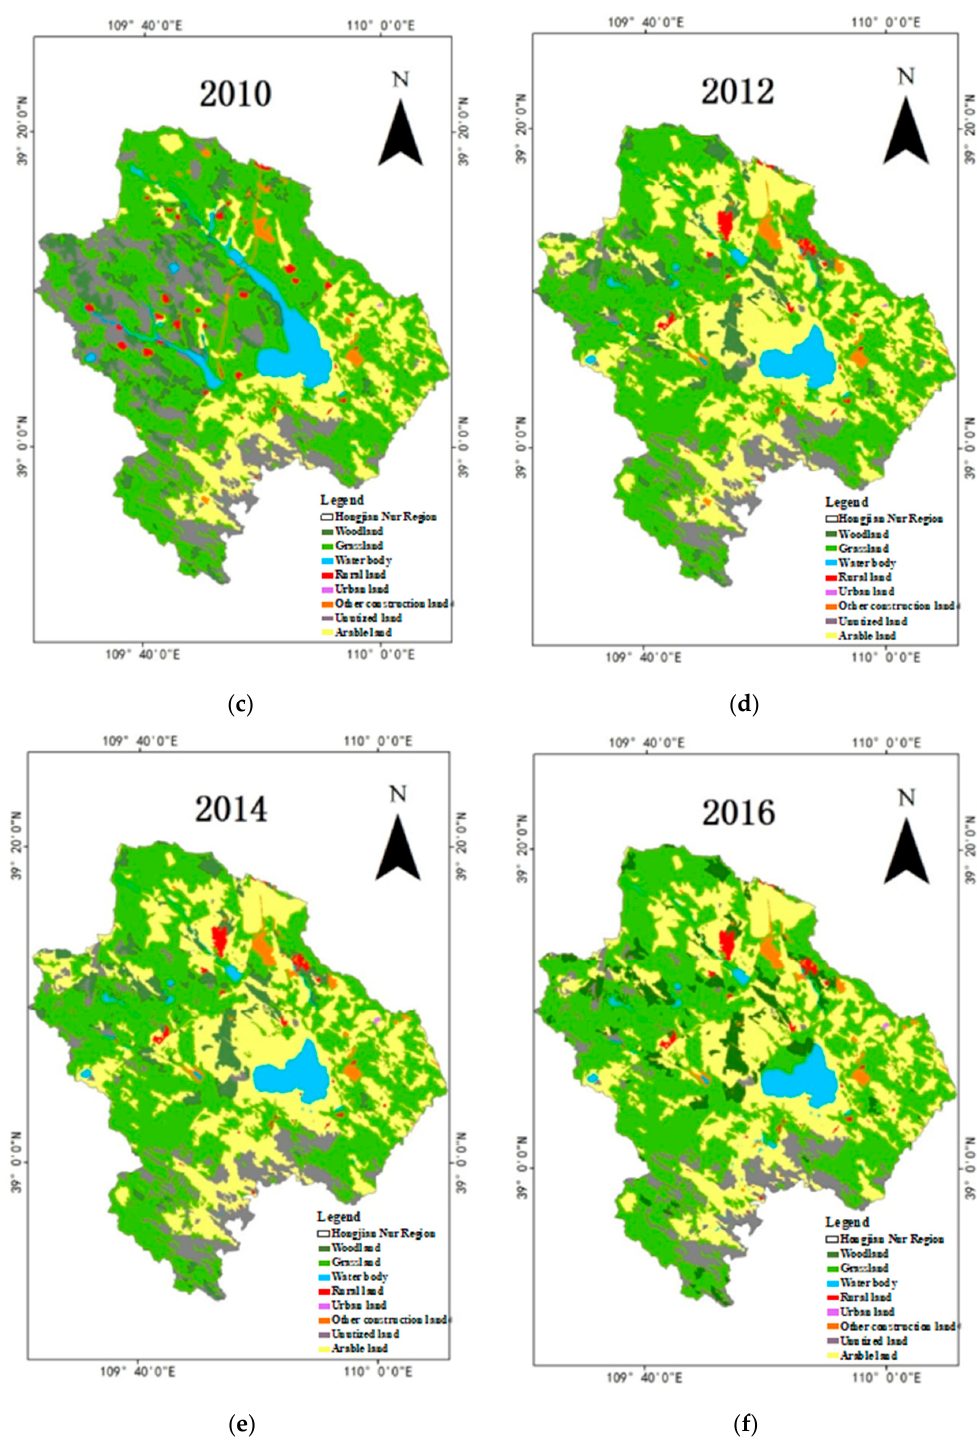
Figure 8. Distribution and change in land use types in the HJN watershed from 2006 to 2016. ( a ) is the spatial distribution and land use types in the HJN watershed in 2006; ( b ) is the spatial distribution and land use types in the HJN watershed in 2008; ( c ) is the spatial distribution and VC in the HJN watershed in 2010; ( d ) is the spatial distribution and land use types in the HJN watershed in 2012; ( e ) is the spatial distribution and land use types in the HJN watershed in 2014; ( f ) is the spatial distribution and land use types in the HJN watershed in 2016.